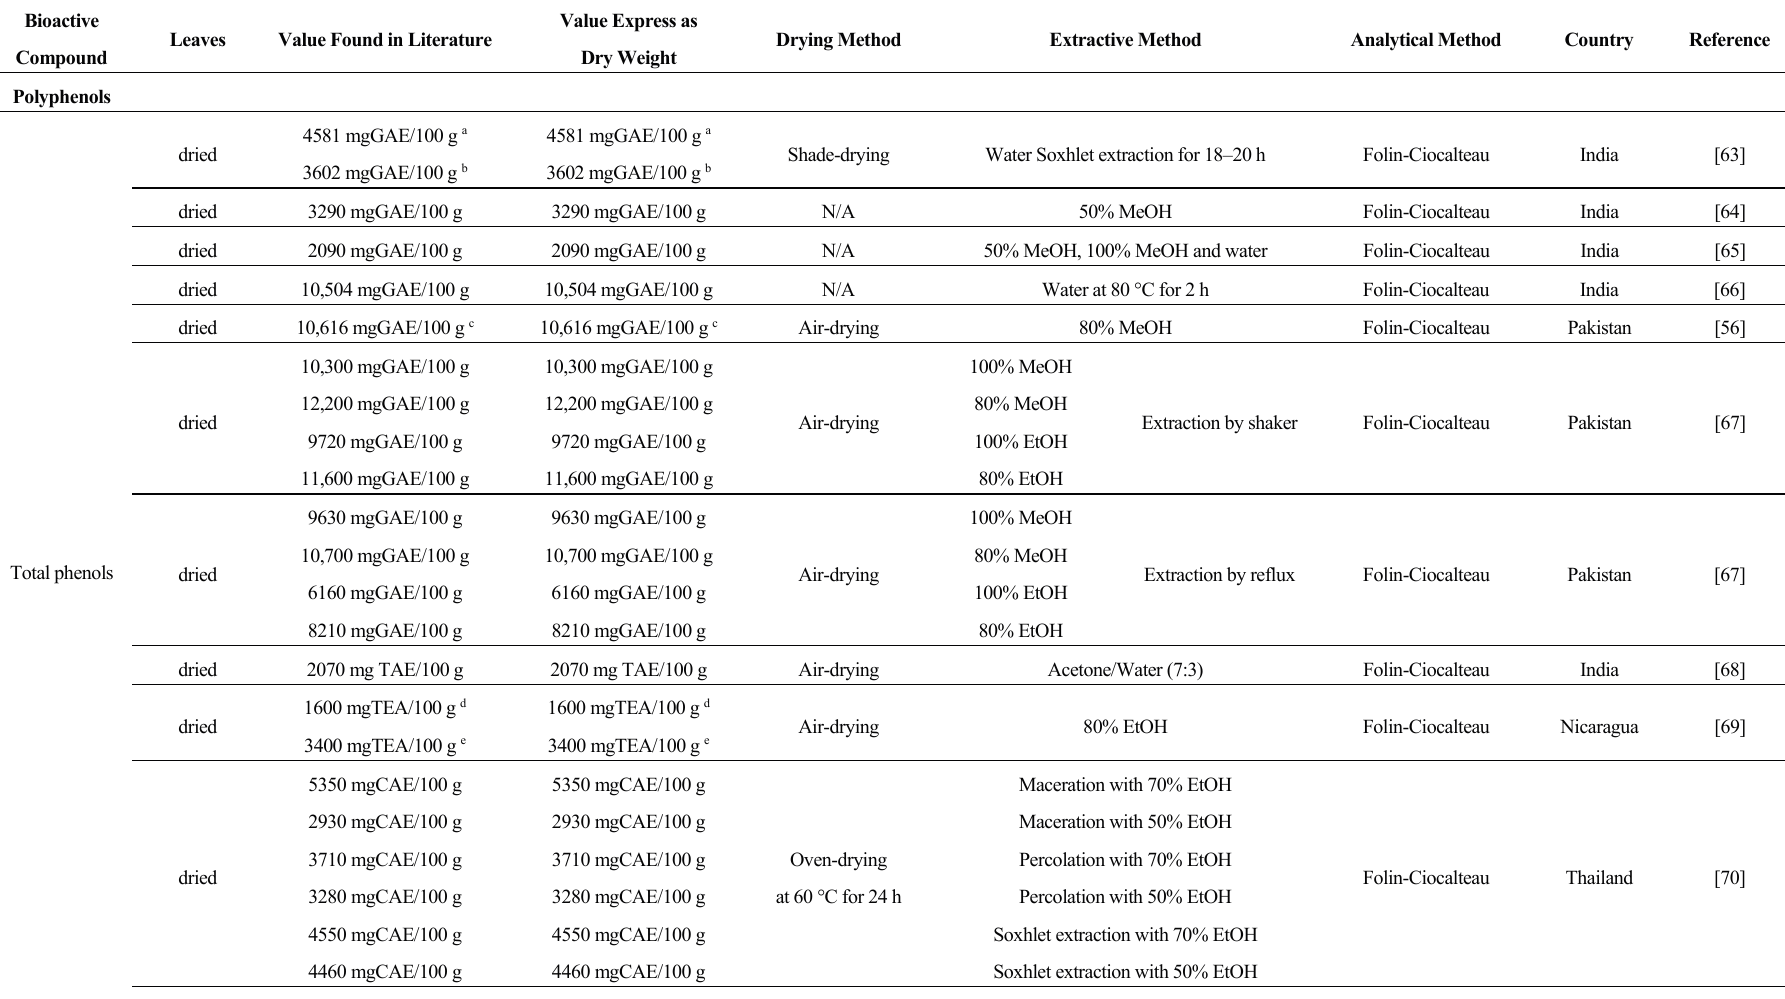
Table 3. Polyphenols content in Moringa oleifera